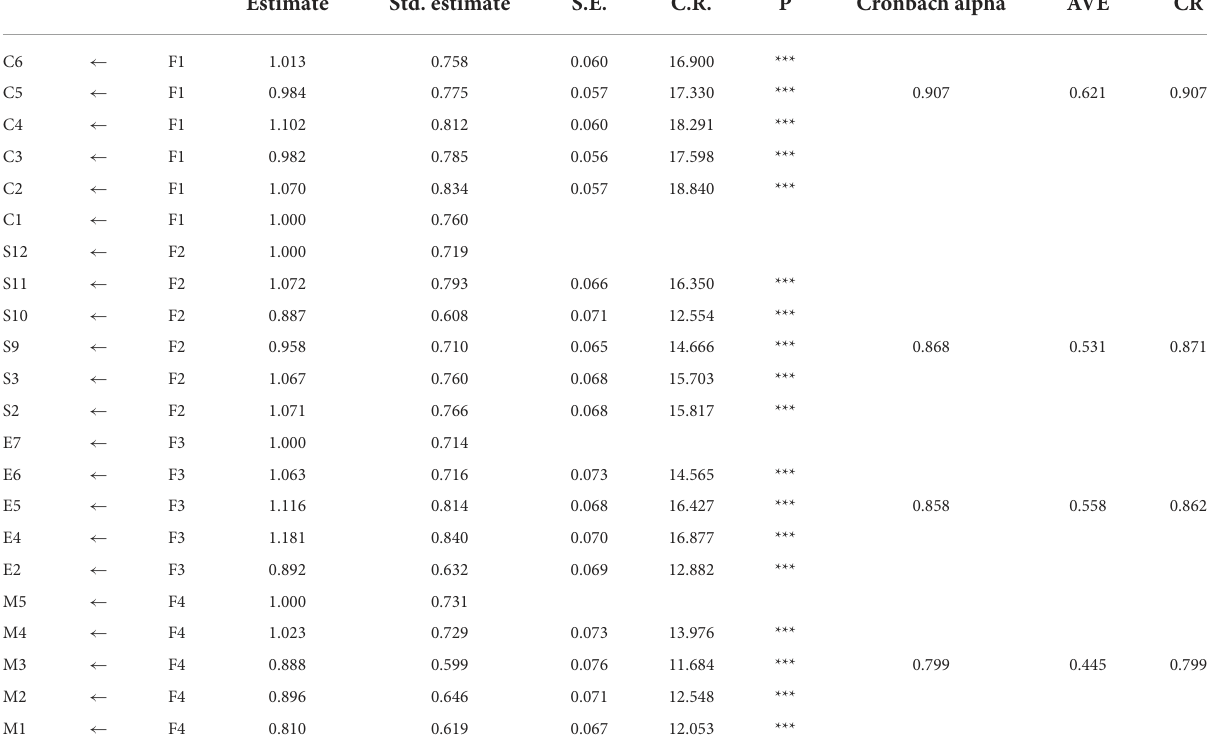
TABLE 5 Confirmatory factor analysis (CFA). Estimate Std.